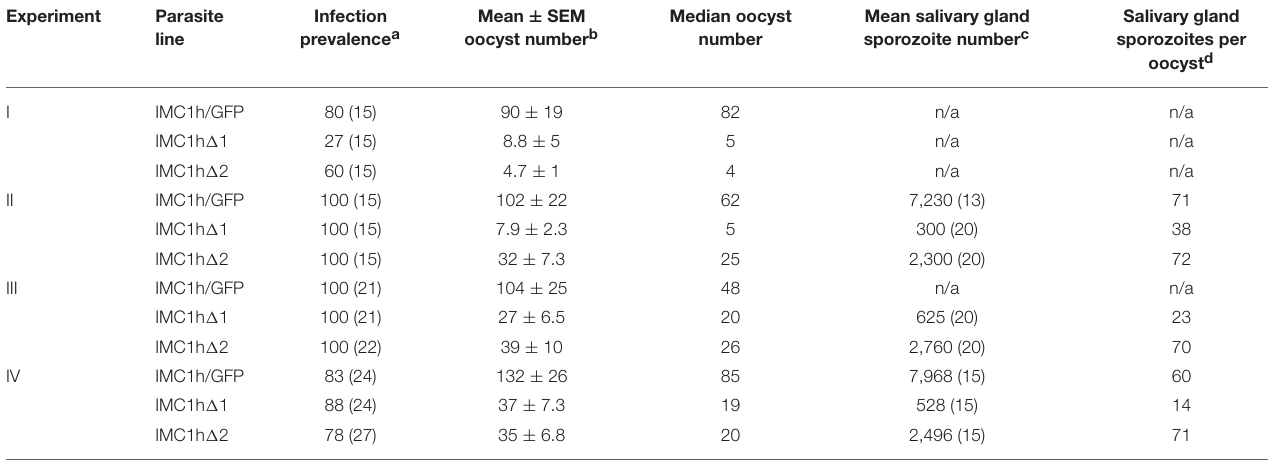
TABLE 1 | Development of IMC1h mutant parasite lines in Anopheles stephensi . Experiment Parasite